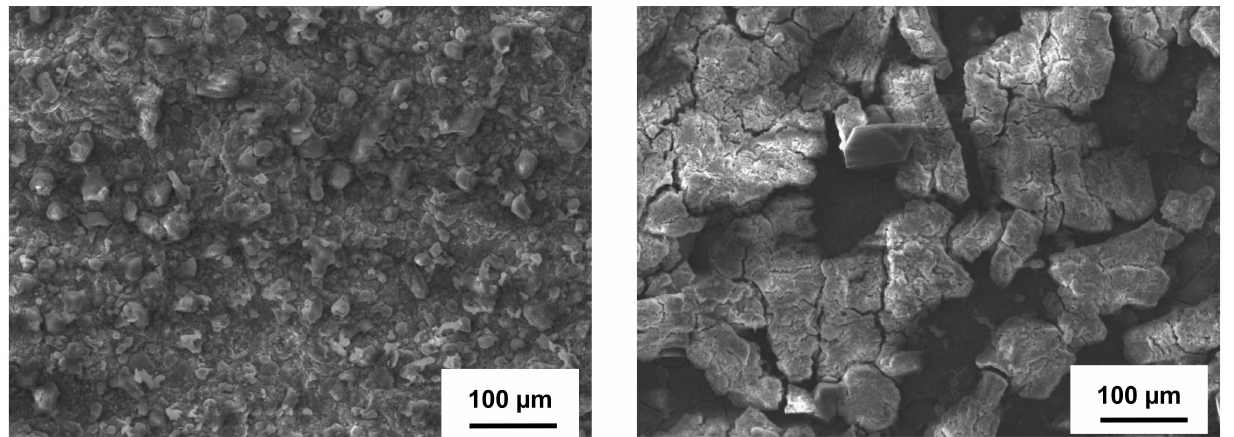
Figure 6. SEM surface morphology of carbon steel with boronized coatings after 504 h of exposure in H 2 S-air at 500 ◦ C, Left—boronized steel (B), Right—boronized steel with a top TiO 2 layer (BT).